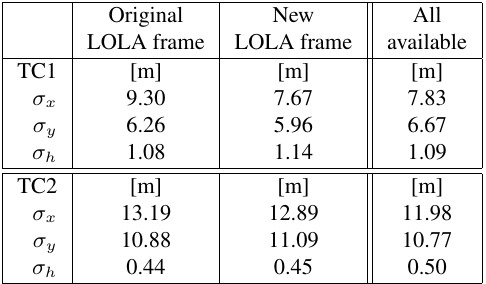
Table 2. Standard deviations of residual displacements of the original LOLA frame (left), the new LOLA frame (middle) and all available LOLA tracks (right) for the near and far side reference DTMs TC1 and TC2. Values are given in meters in local stereographic map coordinates x , y and height h .